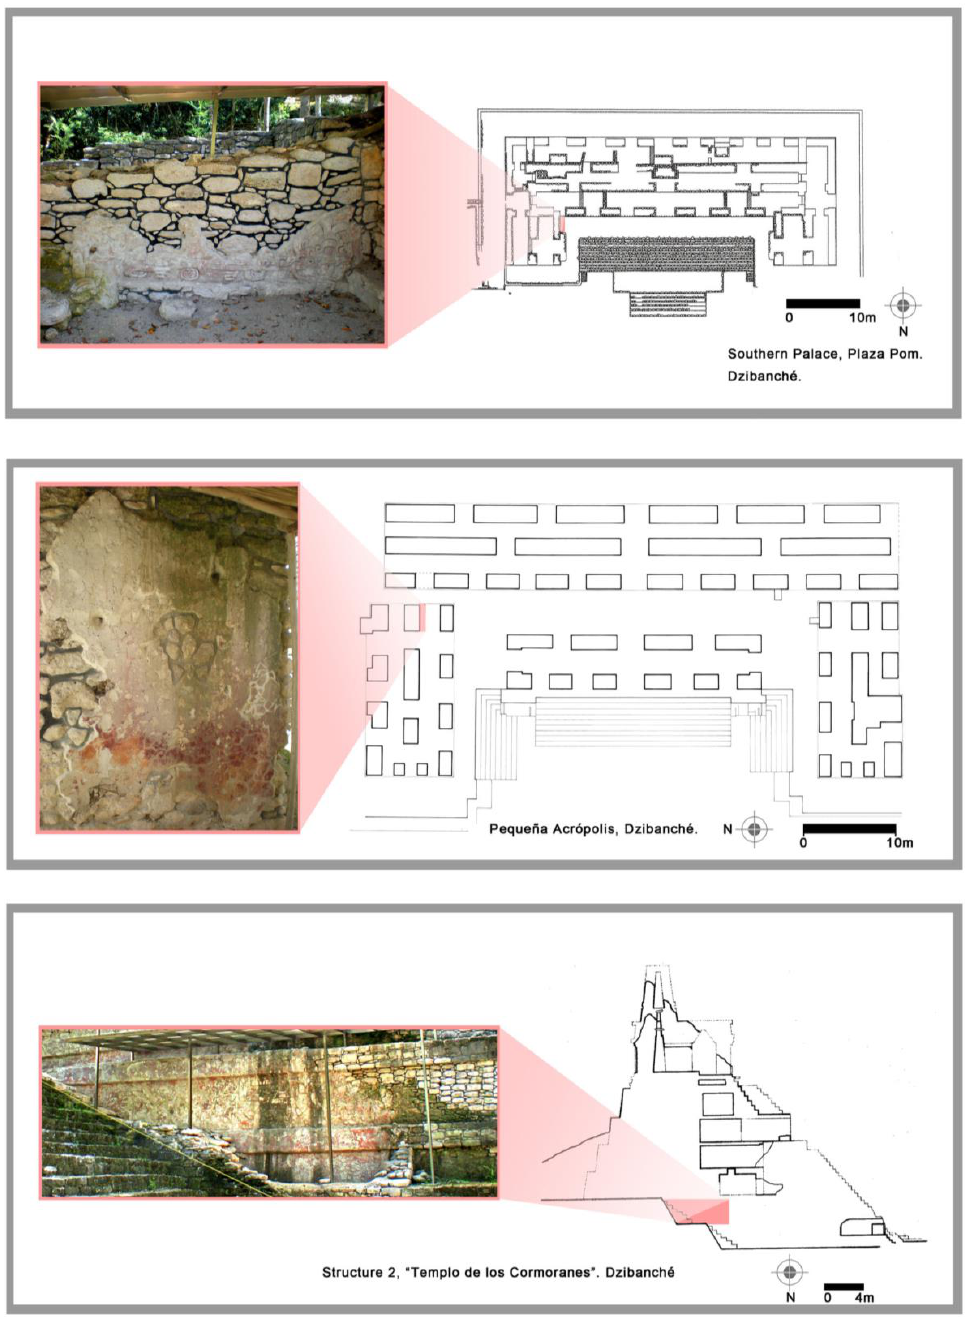
Figure 2. Plasters and stuccoes in Pequeña Acrópolis, Plaza Pom, and Structure 2.